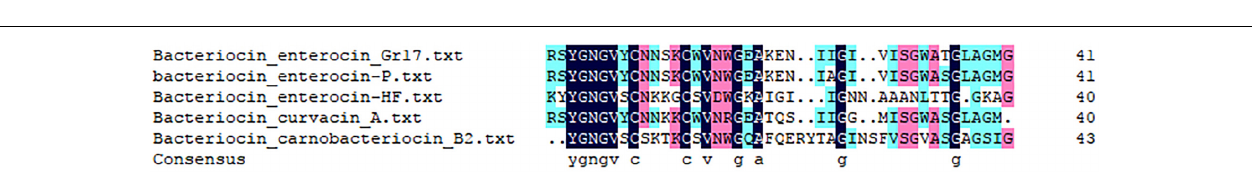
FIGURE 4 | Alignment of reported class IIa bacteriocins. Alignments were obtained using DNAMAN 9.0 with default